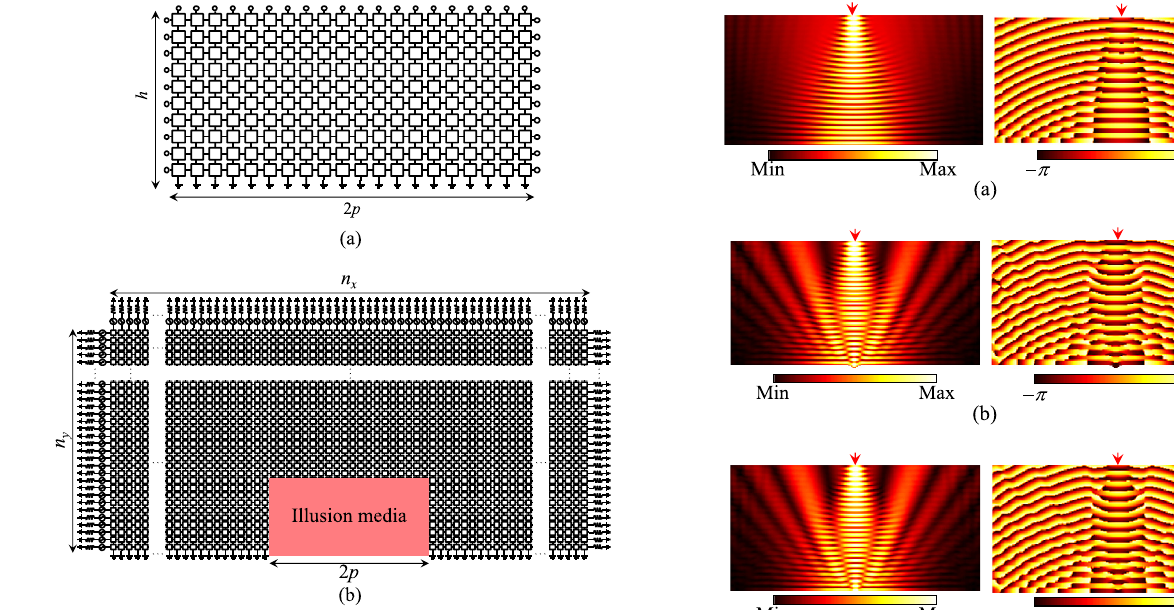
Fig. 8. Con fi gurations of circuit simulations. (a) The groove or bump illusion medium area with 20 (cid:5) 10 unit cells (2 p (cid:5) h = 20 D d (cid:5) 10 D d ) (b) Calculation area with n x (cid:5) n y =300 (cid:5) 150 unit cells.